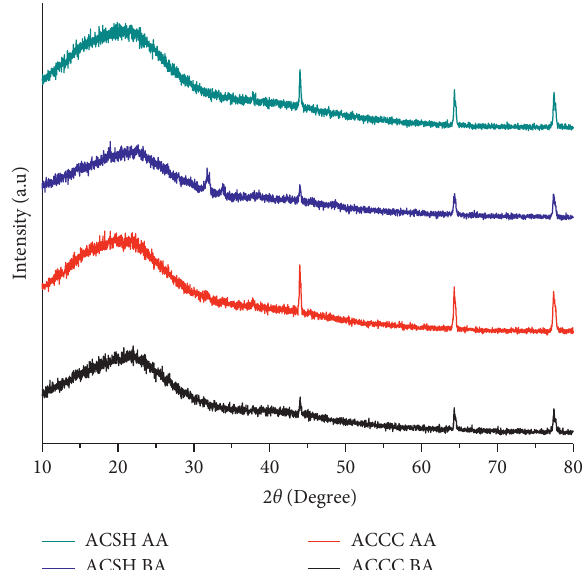
Figure 2: The XRD pattern for activated carbon of corncob before adsorption (ACCC BA), activated carbon of corncob after adsorption (ACCC AA), activated carbon sorghum husk before adsorption (ACSH BA), and activated carbon sorghum husk after adsorption (ACSH AA).